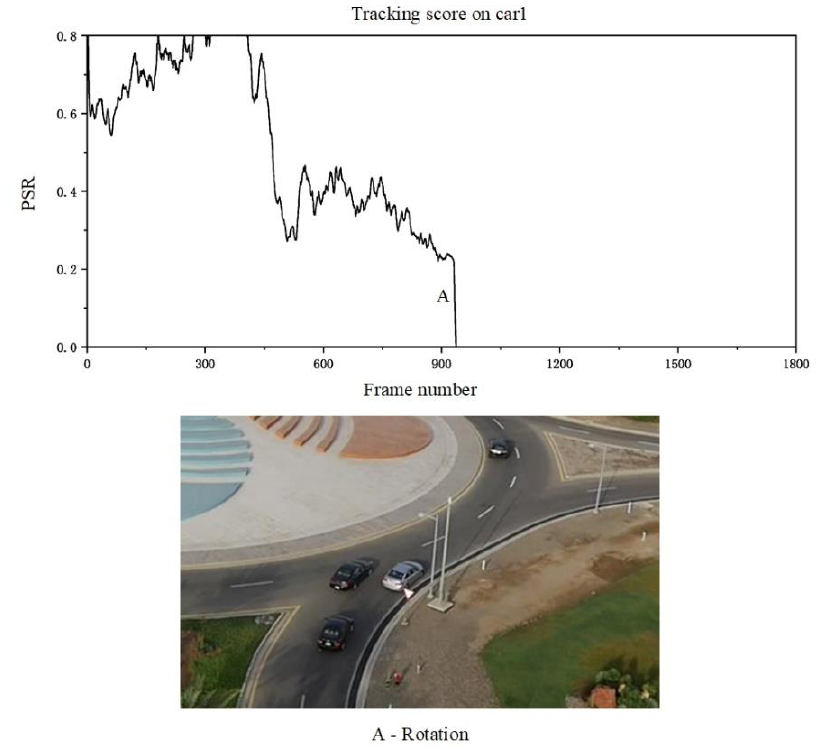
Figure 8. PSR during tracking process with tracker TVGG.